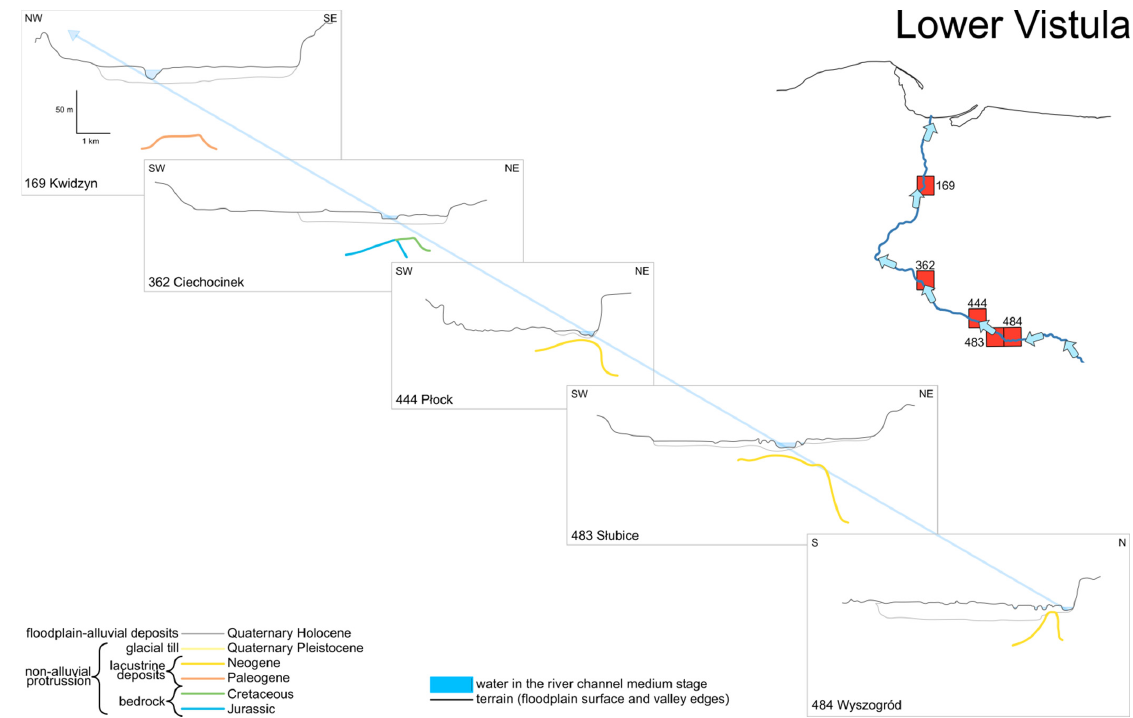
Figure 6. Geological cross-sections through the Middle Vistula River valley, according to [62–66]. Each cross-section presents: water in the river channel during medium stage (blue body); schematic river channel with flow direction (blue line) the valley profile graph with the floodplain surface and the valley’s walls (black), alluvial cover of the floodplain (grey) and non-alluvial protrusion underneath. The color of the non-alluvial protrusion indicates its age according to the stratigraphic chart [43].